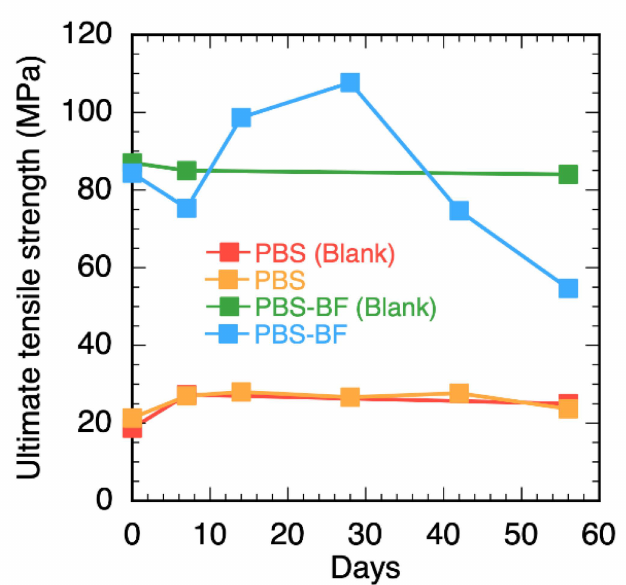
Figure 4. Relationship between the UTS and the time elapsed during the decomposition tests of the PBS and PBS–BF composite